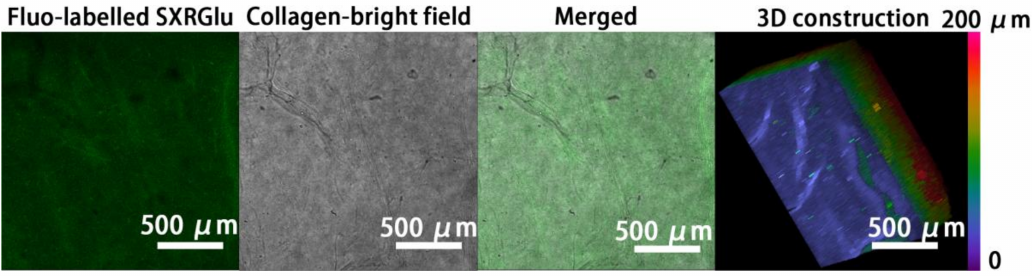
Figure 3. Confocal images of Fluo-labeled SXRGlu through the ECLCU matrices, and 3D reconstruction with the pseudo-color scale indicating depth coding of Fluo-labelled SXRGlu along the Z -axis (0–200 µ m) (scale bar applied to all